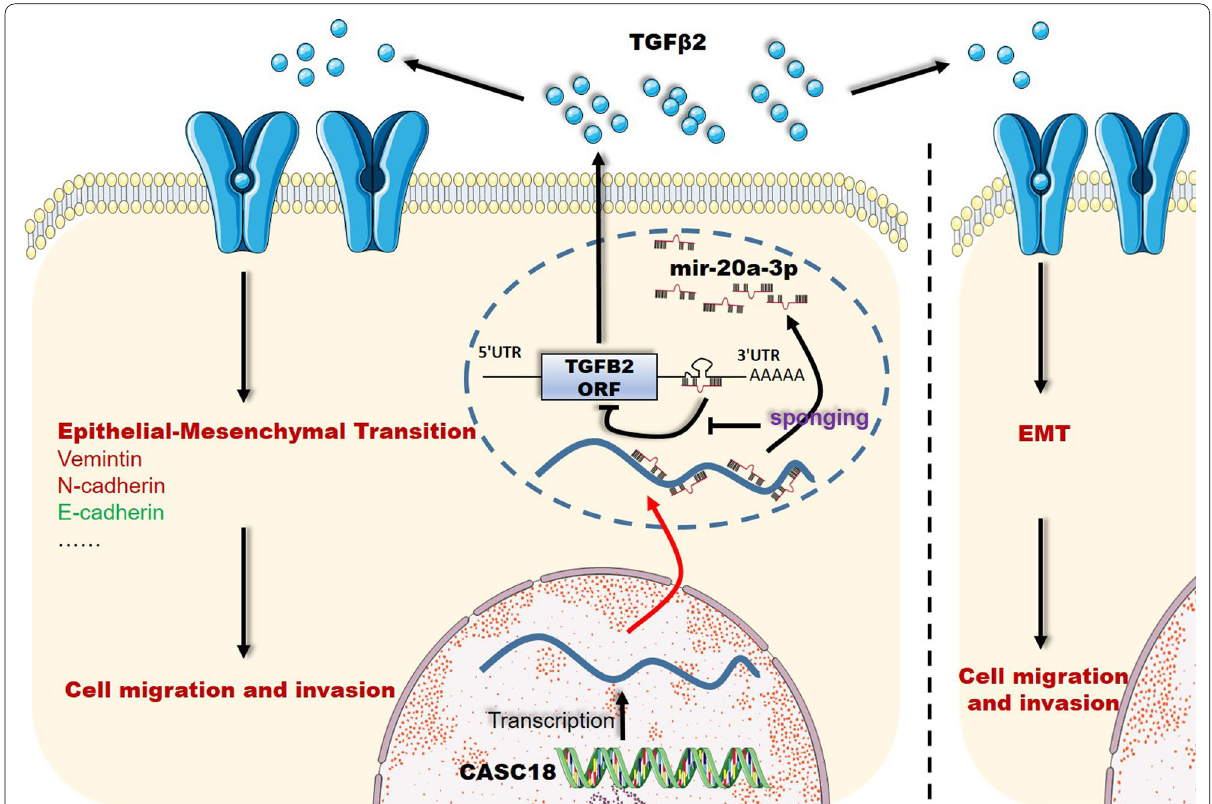
Fig. 8 Schematic diagram of CASC18/miR-20a-3p/TGFB2 ceRNA axis involved in cell migration and invasion of TSCC CASC18 stimulates TGFB2 expression and secretion via sponging miR-20a-3p, and thus promotes TSCC cell migration and invasion through TGFB2-mediated EMT in an autocrine and/or paracrine